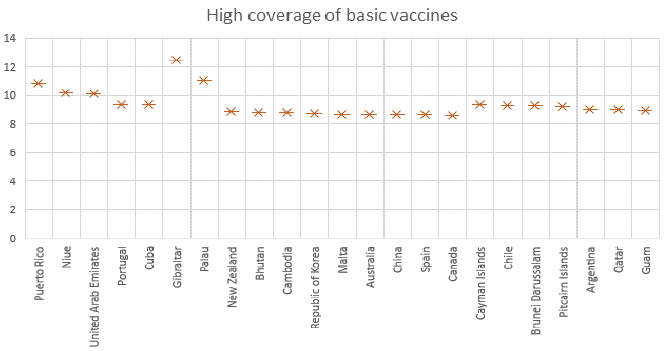
Figure 7. The basic vaccination rates of 23 countries with high vaccination